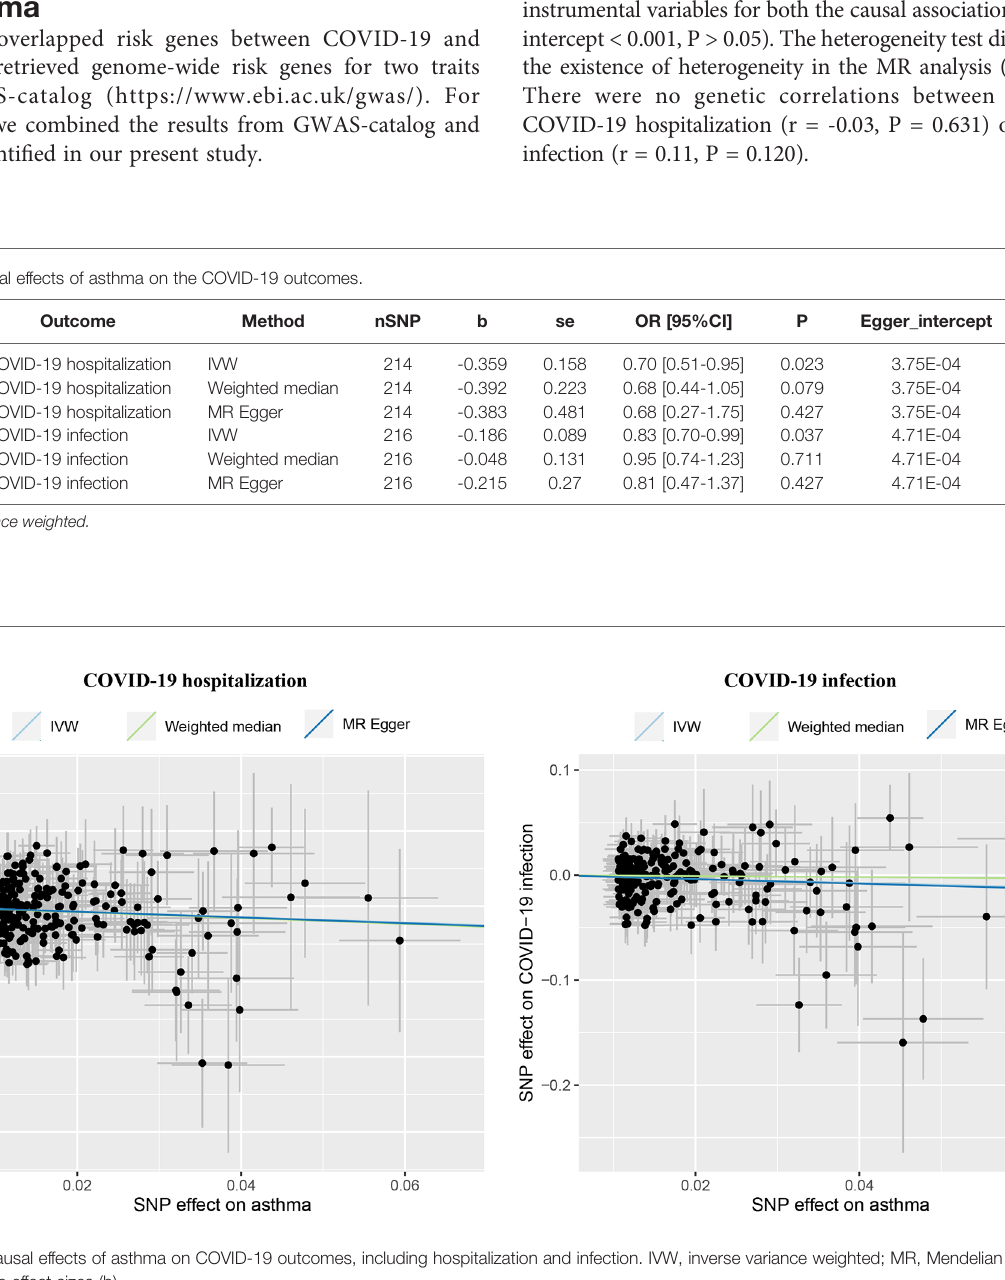
FIGURE 1 | Causal effects of asthma on COVID-19 outcomes, including hospitalization and infection. IVW, inverse variance weighted; MR, Mendelian randomization. The lines denote effect sizes